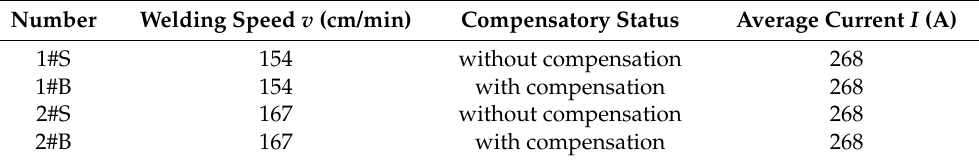
Table 2. Main welding parameters of high-speed welding of stainless